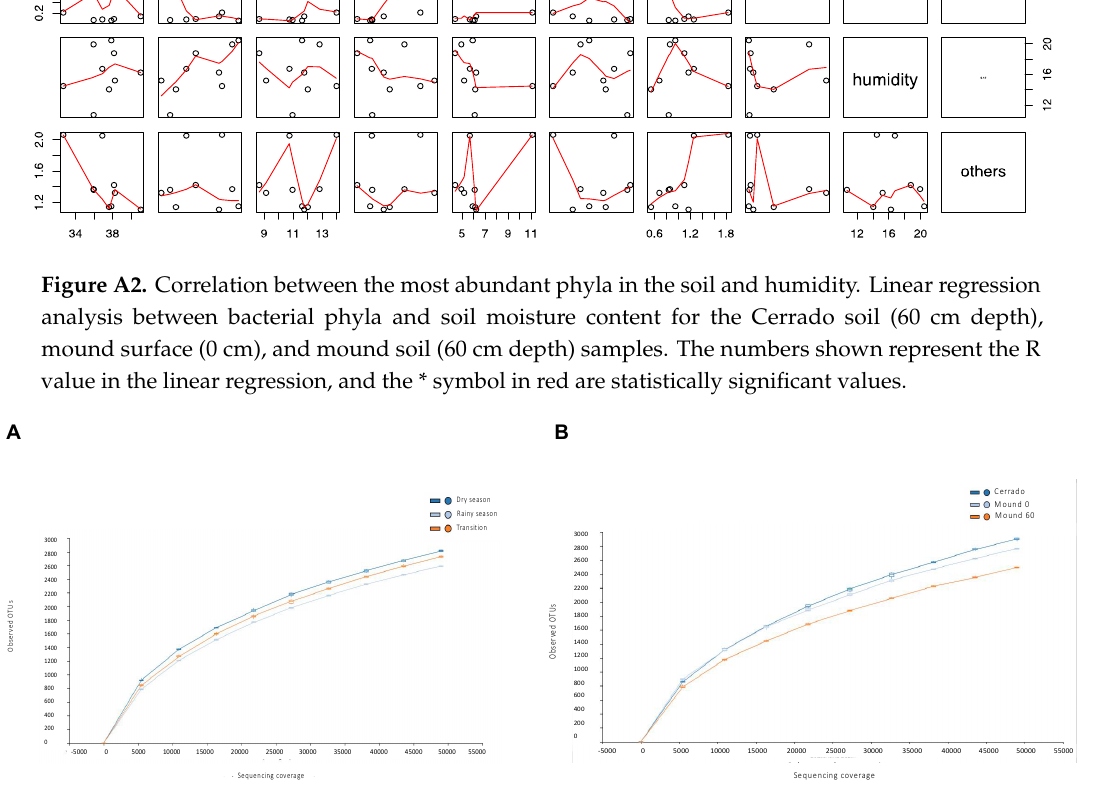
Figure A3. Alpha rarefaction curve of the observed OTUs. ( A ) Cerrado soil bacterial community, collected at different seasons (dry, rainy, and transition) in 2017 and 2018; ( B ) bacterial community in soil samples of the Cerrado (60 cm depth), mound surface (0 cm), and mound soil (60 cm depth) collected in 2017 and 2018.